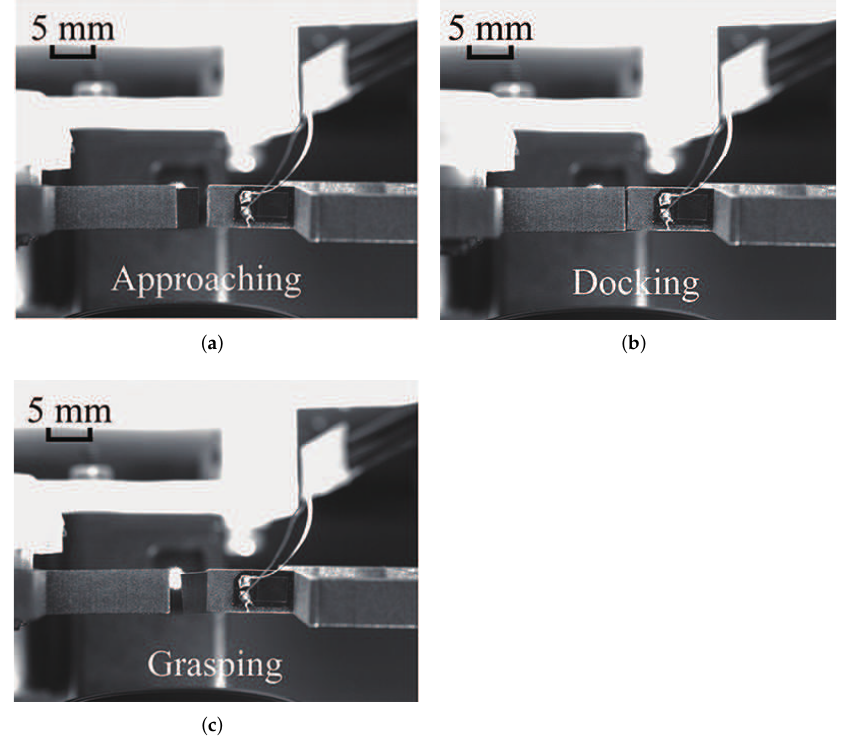
Figure 18. Snapshots of docking experiment using a left gripper and a right gripper. ( a ) Approaching, ( b ) docking, and ( c ) grasped by the designed